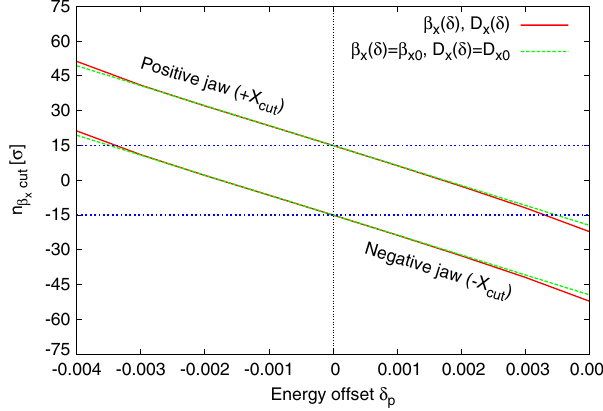
FIG. 6. (Color) Off-momentum phase space cut at the primary collimator TCP.6L3.B1 (with D x ¼ 2 : 2 m ).